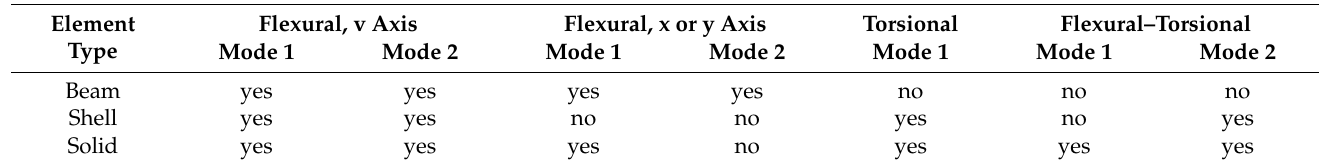
Table 1. Buckling modes reproduced by each element type in an LBA (examples of the buckling modes can be found in Figure 6).